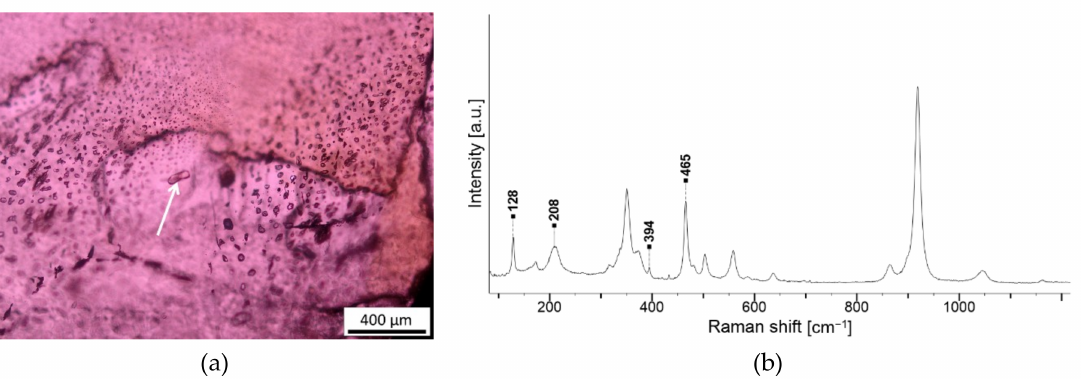
Figure 9. Inclusions in garnet G3 of fibula NA401. ( a ) Xenomorphic inclusion of quartz. Transmitted light, parallel polars; ( b ) Raman spectrum of quartz in almandine garnet.